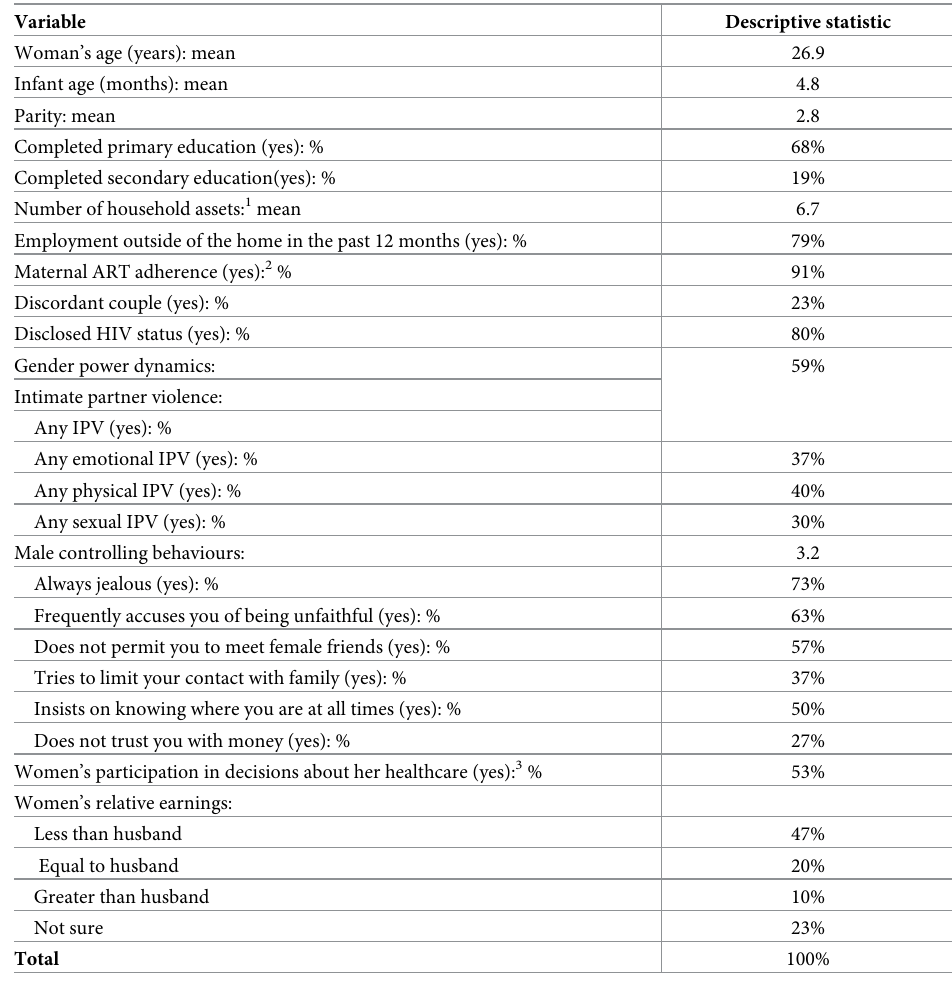
Table 1. Sample characteristics (n =